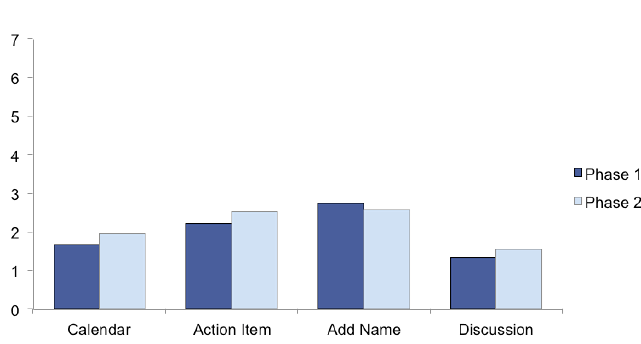
Figure 1. Comparison of mean ASQ scores across scenarios for phase 1 and phase 2 data. Note: Lower scores indicate higher usability.